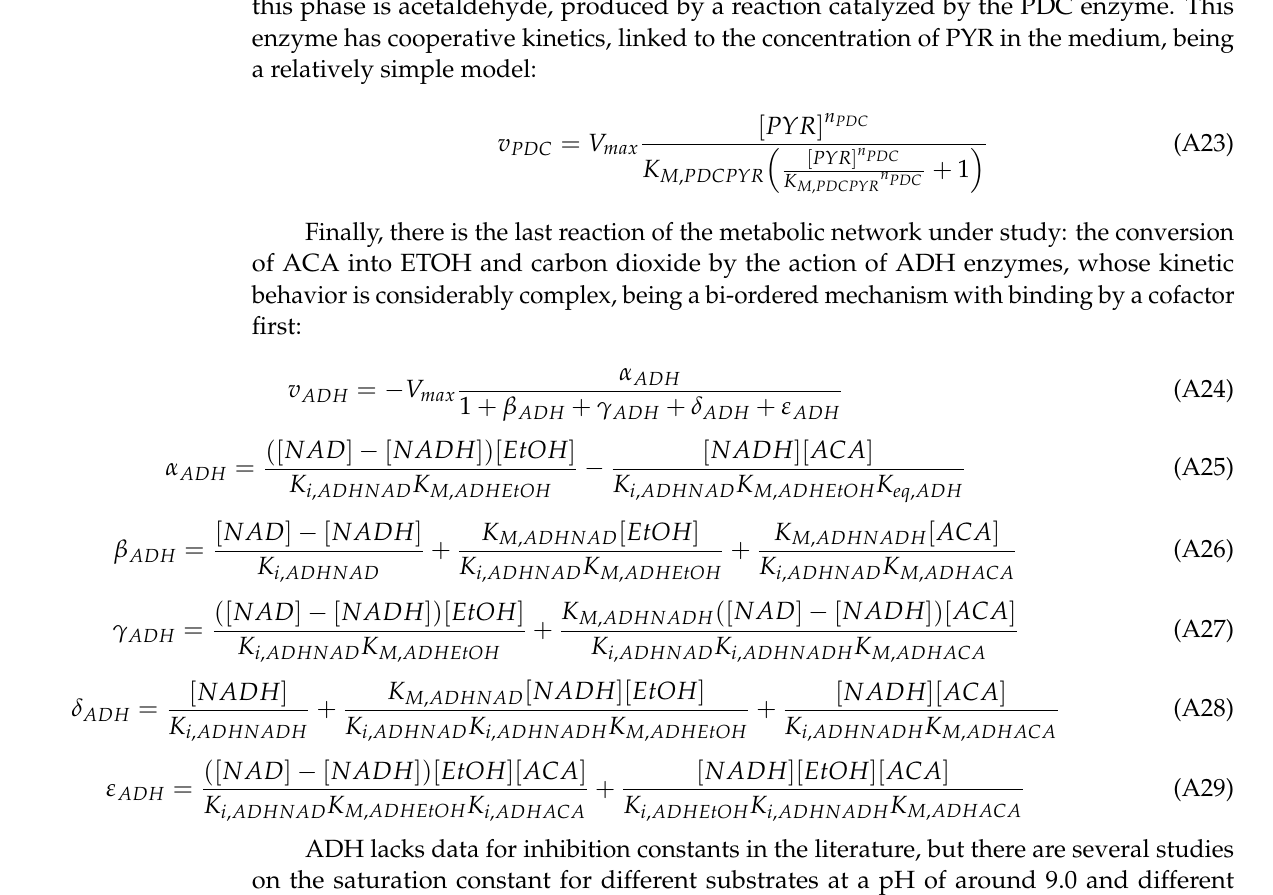
) of the SR and CR models according to s